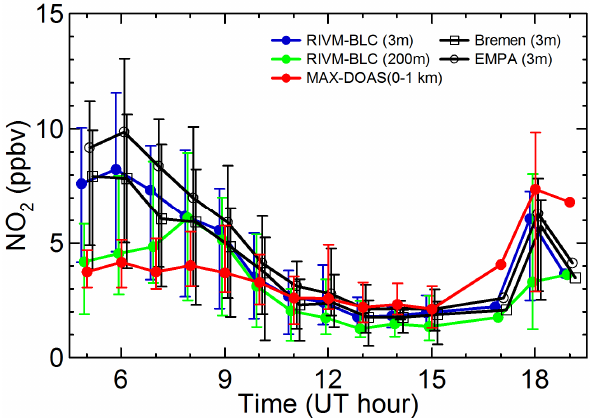
Fig. 8. Median diurnal variations of NO 2 seen from MAX-DOAS and in situ observations for the period June 12-July 2, 2009, when all five different types of observations were available. MAX-DOAS data represent the mean VMR for 0-1 km, while the others represent VMRs at 3 m, except RIVM-BLC (200m) representing VMRs at 200 m.